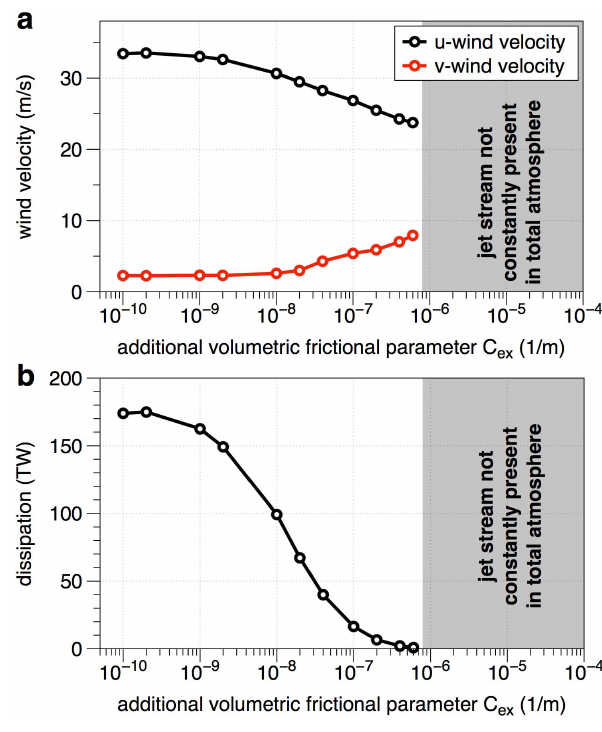
Fig. 5. Sensitivity of jet stream dynamics to the intensity of ki- netic energy extraction C ex from jet streams with v jet =25ms − 1 in terms of (a) the mean u - and v -wind velocities at 200hPa and (b) the dissipation rate within those atmospheric regions at which the wind velocity is > 25ms − 1